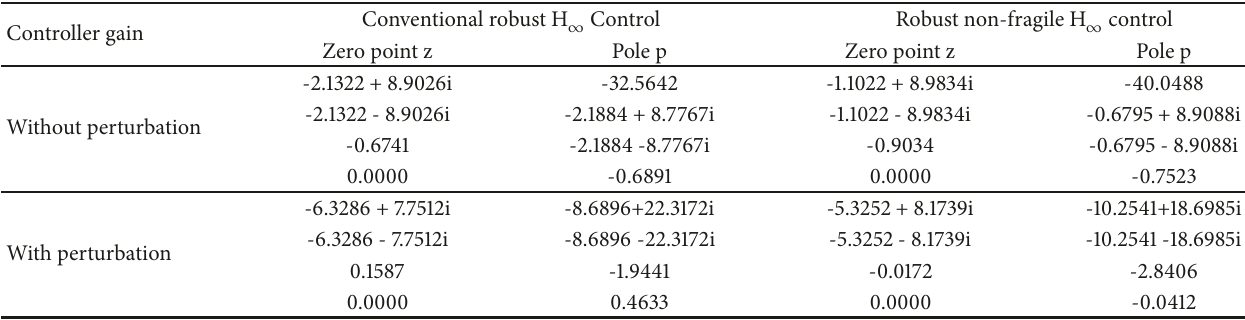
Table 5: Vehicle body vibration acceleration zero pole